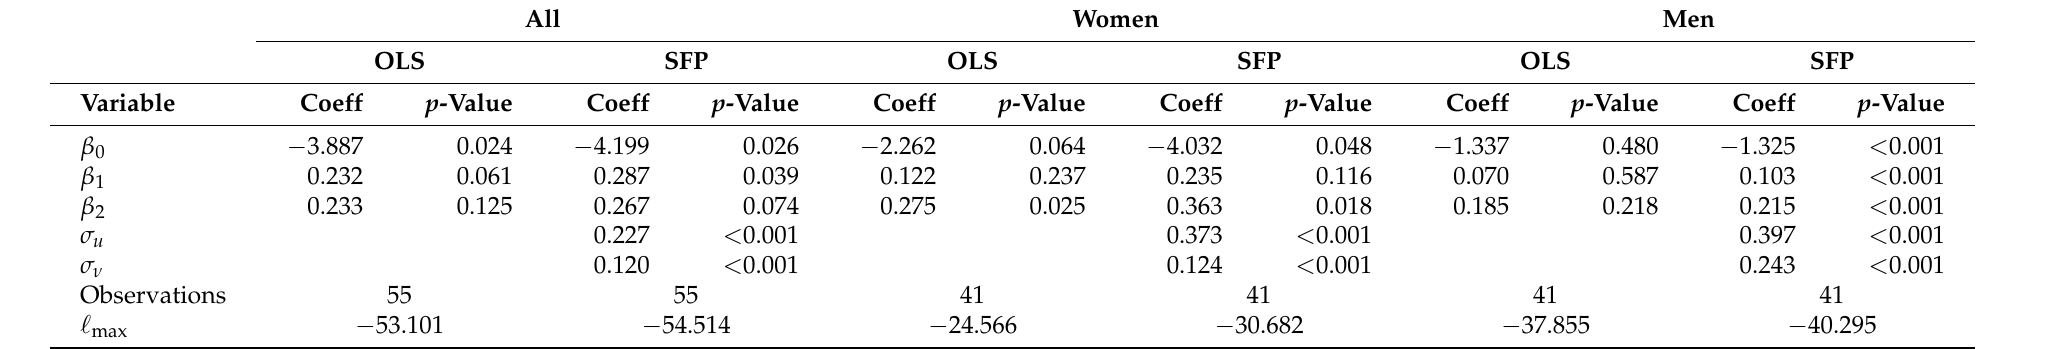
Table 5. Estimation of the model considering the olympic years in 2008, 2012, and